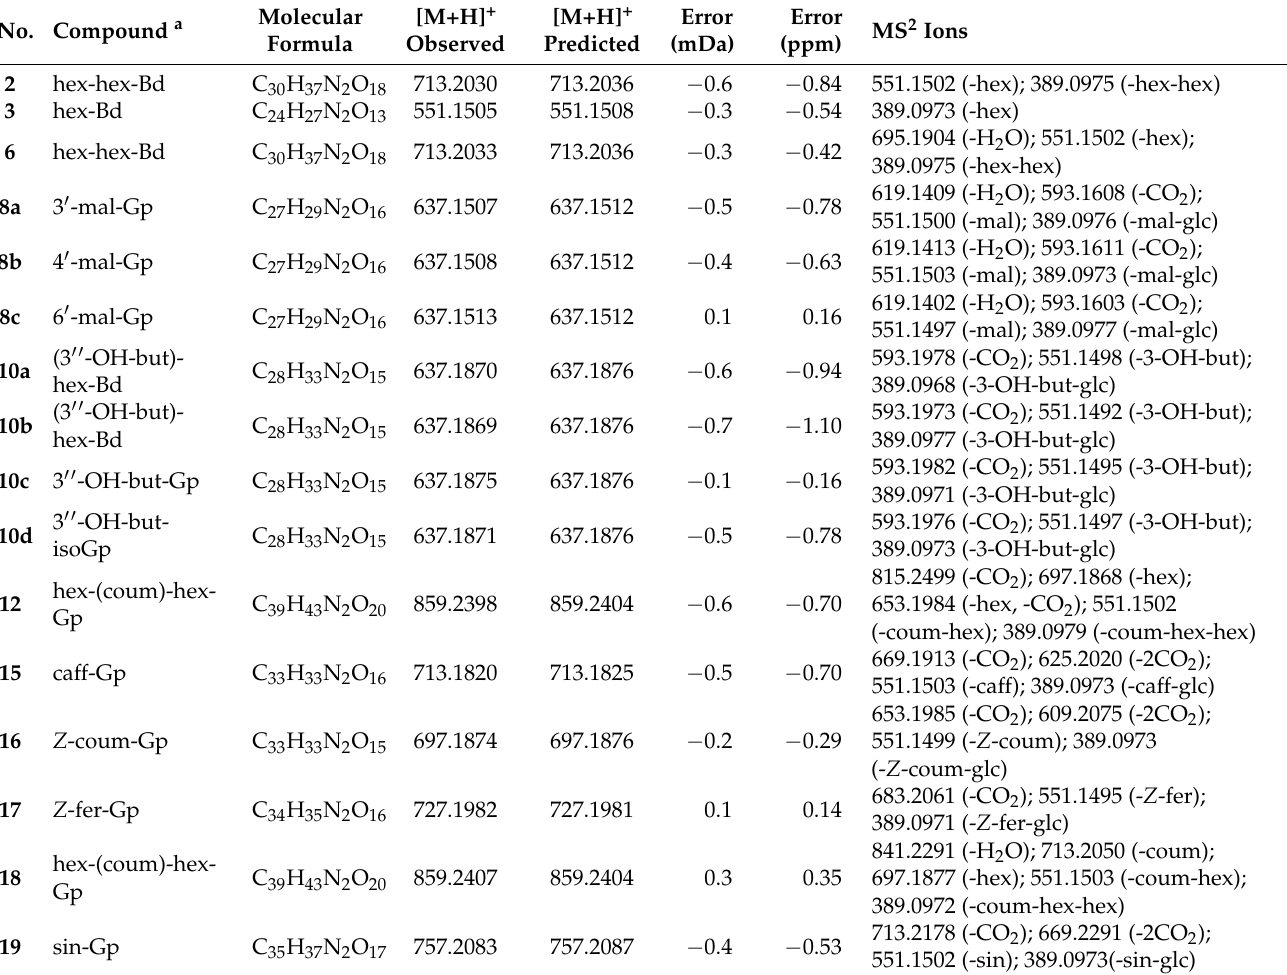
Table 2. High-resolution mass spectrometric data (obtained by the Orbitrap system) in identification of novel betacyanins possessing non-nitrogenous substituents present in B. alba and B. alba var. ‘Rubra’ fruit